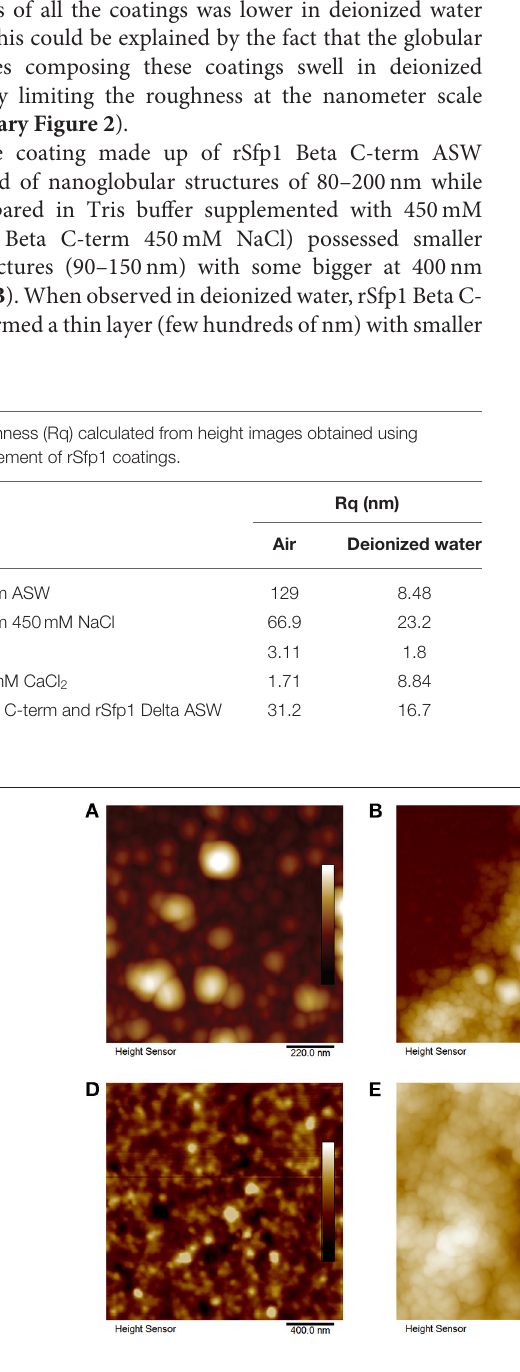
Frontiers in Mechanical Engineering |